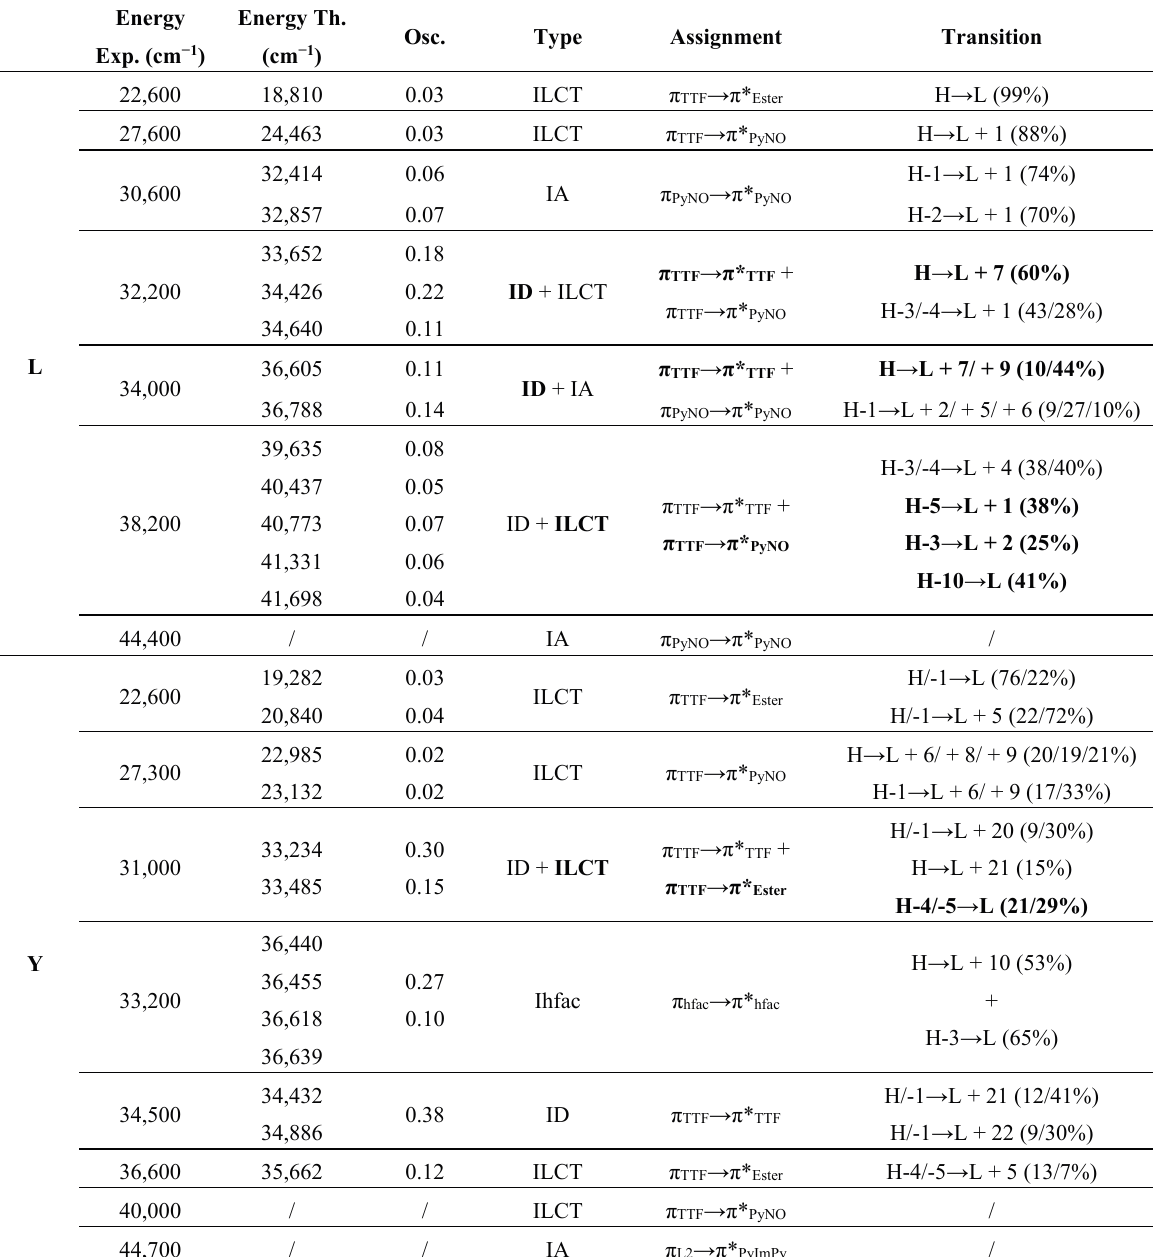
Table 4. TD-DFT calculated excitations energies and main composition of low-lying electronic transitions for L and the Y (III) analogue of 1 and 2 . In addition, charge transfer and the pure intramolecular transitions are reported. ID, IA, Ihfac, H, and L represent respectively the intramolecular TTF (Donor), 2-pyridine- N -oxide (Py) (Acceptor) or hfac − ligand, HOMO and LUMO; therefore ILCT stands for Intra-Ligand Charge Transfer (from TTF to 2-pyridine- N -oxide (PyNO) or methyl ester (ester)). The theoretical values are evaluated at the PCM(CH 2 Cl 2 )-PBE0/SVP level of approximation. Bold style is used to highlight the